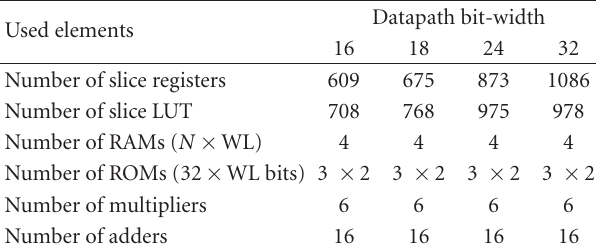
Table 1: Hardware resource analysis of the SOC fading